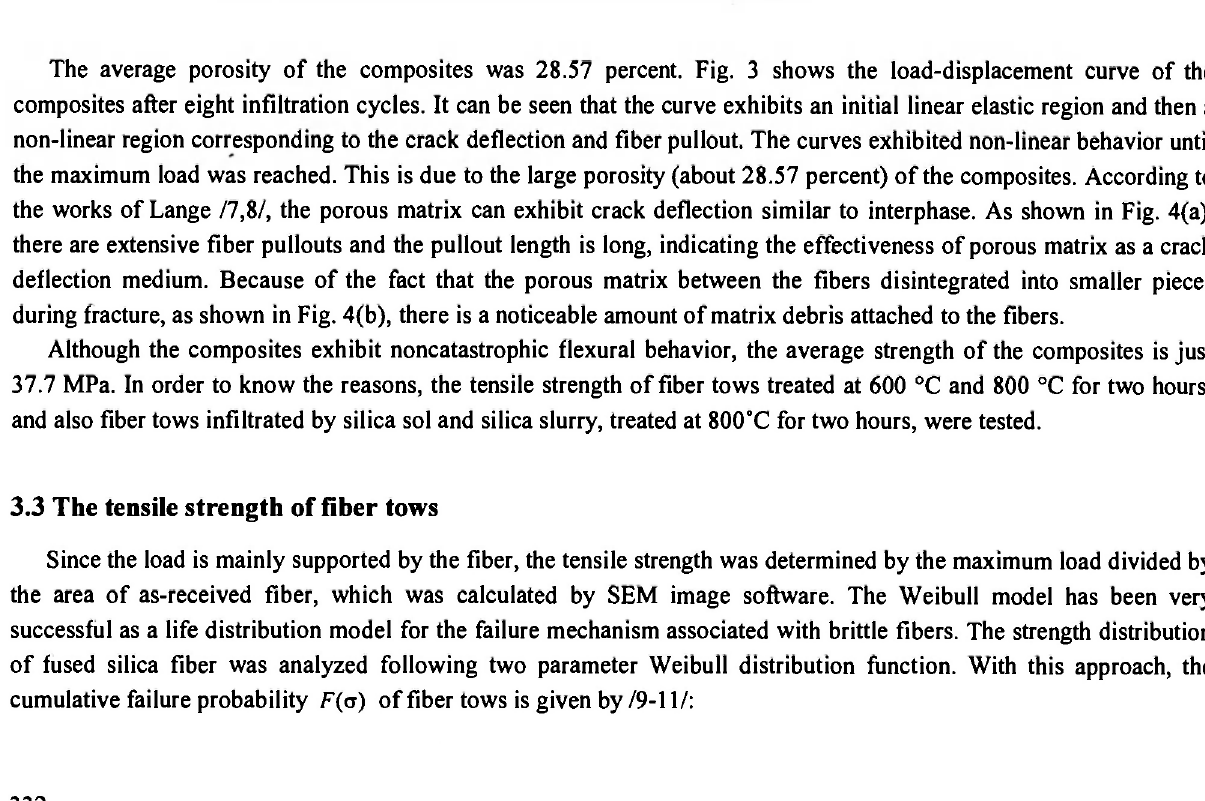
Fig. 3: Load-displacement curves of the composites